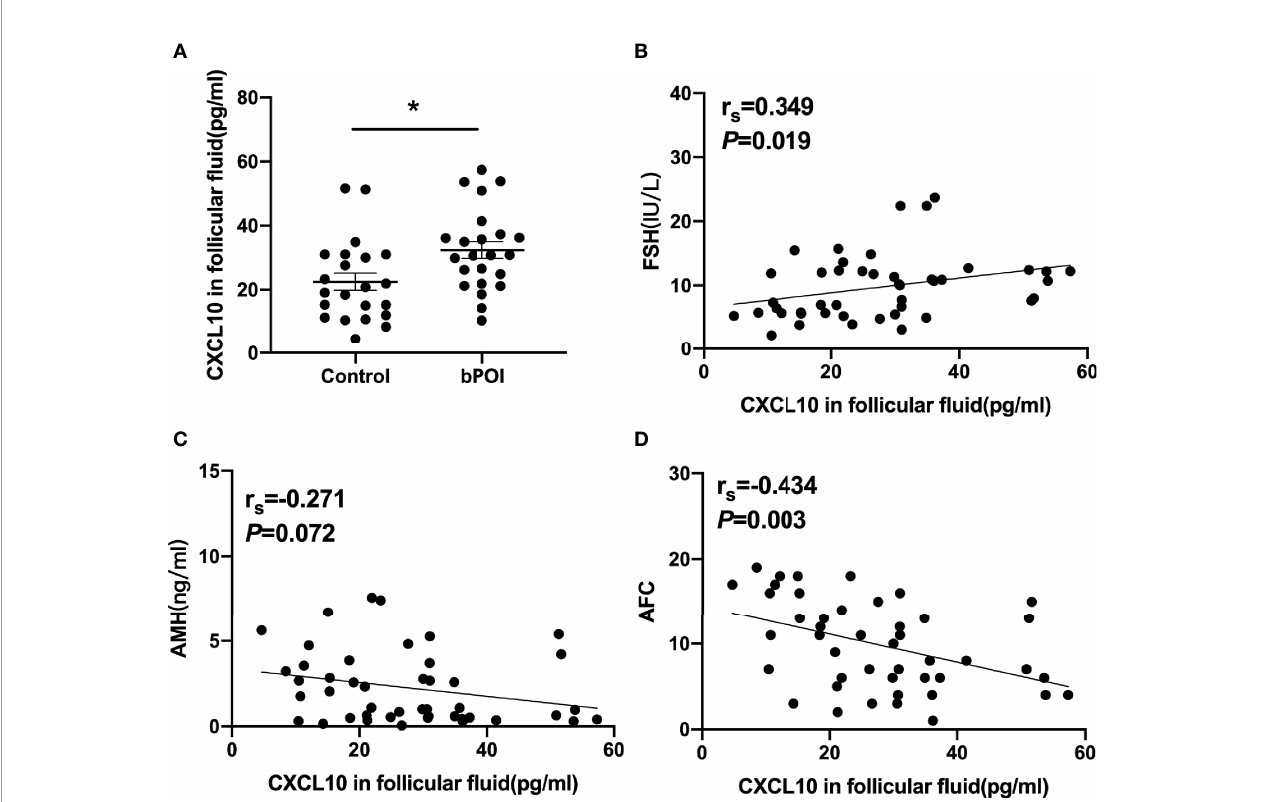
FIGURE 2 | CXCL10 accumulation in follicular fl uid of bPOI patients. (A) CXCL10 levels in follicular fl uid from bPOI patients ( n = 23) and control subjects ( n = 22). (B) Positive correlation between CXCL10 levels in follicular fl uid and serum FSH levels. (C) No correlation between CXCL10 levels in follicular fl uid and serum AMH levels. (D) Negative correlation between CXCL10 levels in follicular fl uid and AFC levels. * P < 0.05 vs.